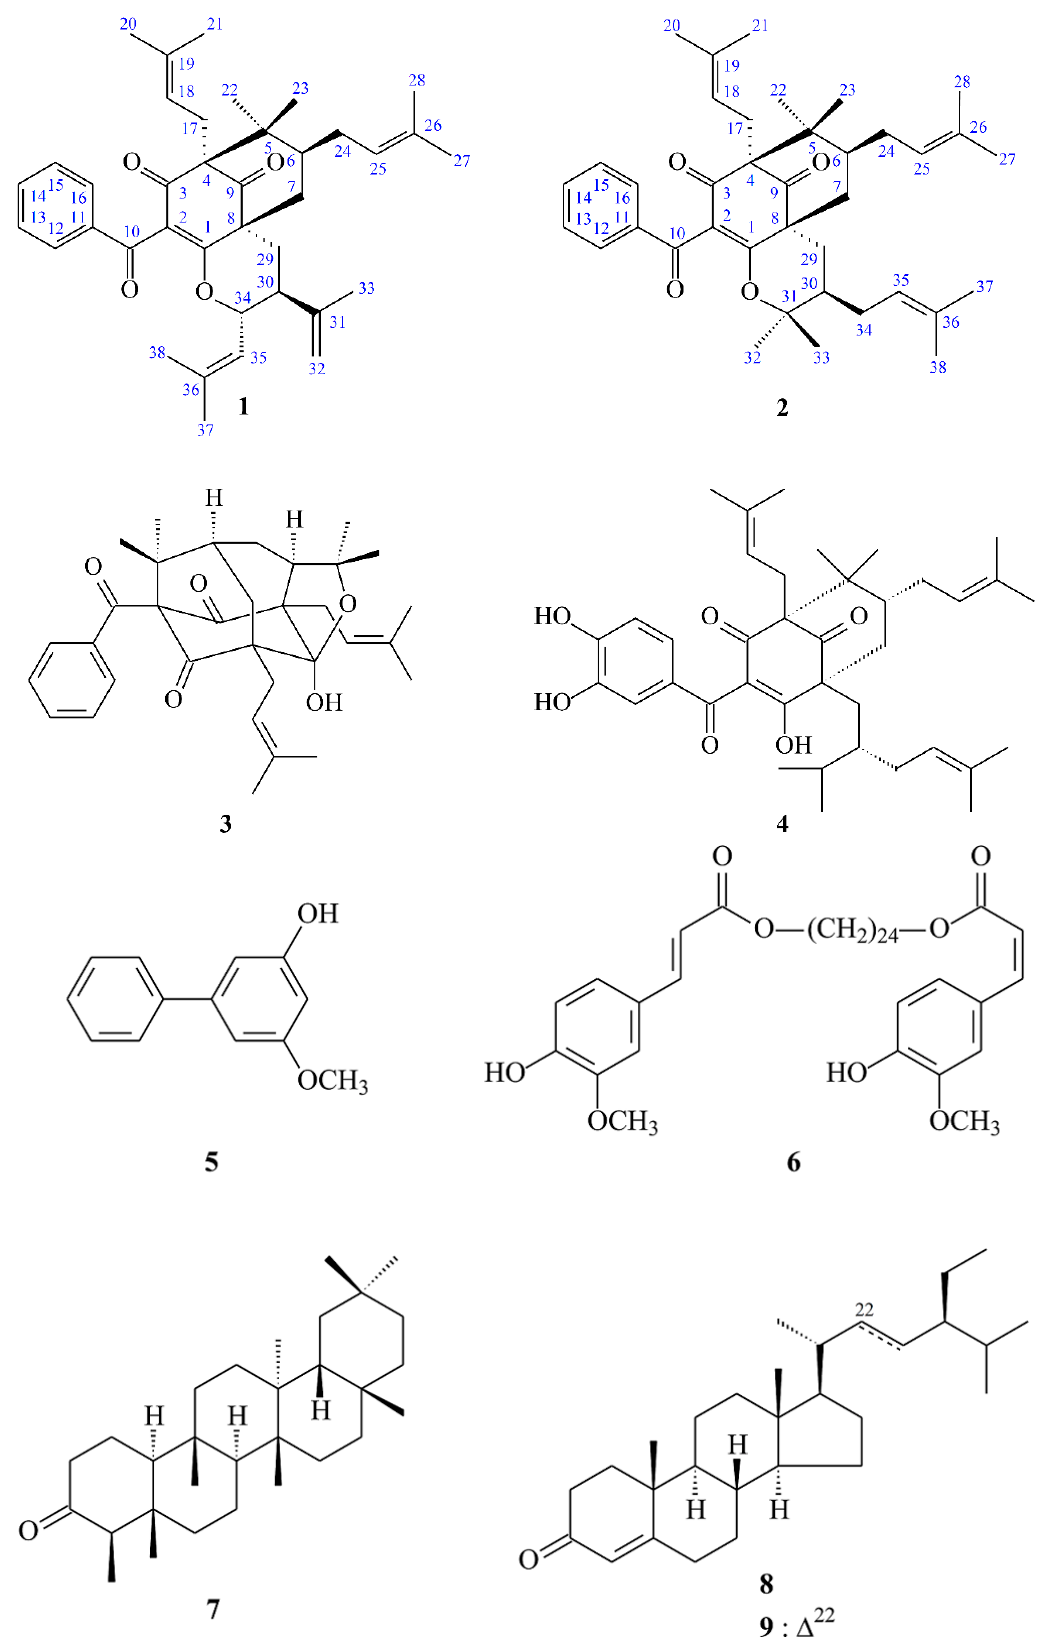
Figure 1. The chemical structures of compounds 1 – 9 isolated from Garcinia multiflora .